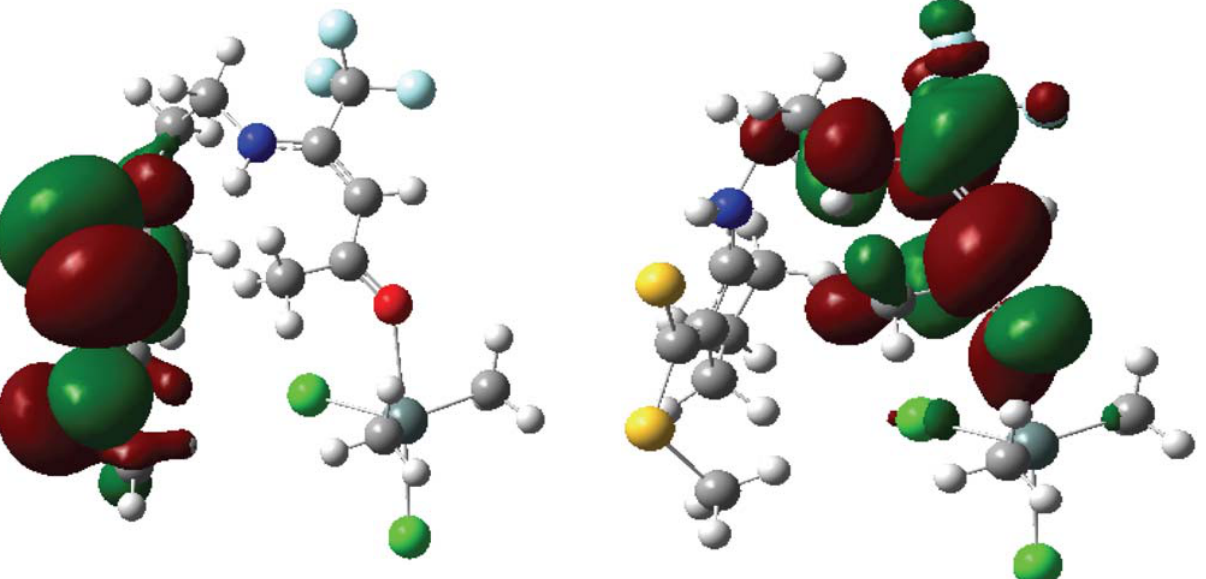
Figure 4. HOMO (left) and LUMO (right) orbital of [ SnMe